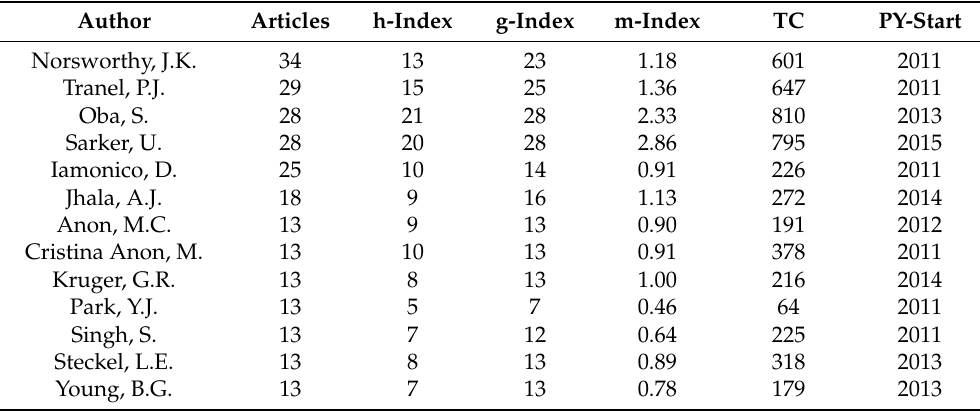
Table 2. A total of 20 leading authors on amaranth-related research from 2011 to